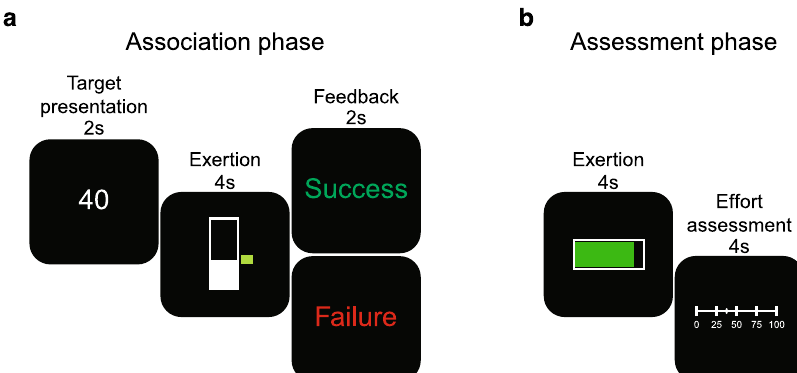
Fig. 1 Experimental paradigm. a Association phase; Participants were trained to associate between grip force exerted on a handheld dynamometer and effort levels from 0 to 100 (80% of maximum voluntary contraction (MVC)). Each trial began with presentation of the target, followed by an effortful grip with real-time visual feedback of the exerted force represented as a bar that increased in height with increased exertion. A target zone was also presented, and participants were asked to maintain their exerted force within this target zone. The target zone turned green when exerted force was within the target and stayed red otherwise. Feedback of success or failure was provided at the end of each trial. b Assessment phase; Participants were instructed to exert an unknown amount of force and assess how much they exerted. On each trial, the full bar corresponded to a target effort level that was unknown to participants. Successfully achieving the effort target resulted in the bar turning from red to green. Following exertion, participants selected the effort level they believed they had exerted. Participants were not given feedback about accuracy of their effort consistent with previous studies of isometric force production which have shown that variability in motor output increases proportionally with the amount of exertion (i.e., signal-dependent noise) 16 – 18 . In the PD group, we found that dopamine availability interacted with the effect of mean exertion on exertion variability (Fig. 2C; Linear mixed model, β = − 0.04, t = − 2.25, df = 1820, p = 0.025). When participants were in the ON dopamine condition, they exhibited less of an increase in exertion variability as exertion increased, compared to the OFF condition. We found that control participants ’ exertion variability matched participants in the OFF condition (Linear Mixed Model; β = − 0.0030912, t = − 0.11424, df = 2634, p = 0.90906, and the ON condition (Linear Mixed Model; β = − 0.042854, t = − 1.6234, df = 2634, p = 0.10462). These results align with our hypothesis of increased dopamine availability facilitating a reduction in exertion varia- bility during effortful motor output. During the assessment phase, we found that Control and (Fig. 2D; Linear mixed model, β = 1.226, t = 21.452, df = 2634, p = 3.1948e − 94) PD participants in the ON and OFF conditions (Fig. 2D; Supplementary Table 3; Linear mixed model, β = 1.24, t = 17.49, df = 1820, p = 1.91e − 63), recalled assessments of effort increased with their mean exertion. In the PD group, there was a signi fi cant interaction between dopamine treatment condition and mean exertion on assessments of effort (Linear mixed model; Fig. 2D; β = − 0.23, t = − 2.79, df = 1820, p = 0.005), indicative of increased dopamine availability having a dampening effect on increases in effort assessment with exertion. To further assess how dopaminergic availability was related to participants ’ accuracy of effort assessment we examined the slope of the relationship between participants ’ mean exertion and levels of assessment - perfect effort assessment would result in a slope of unity. In the dopamine OFF condition, the average slope was signi fi cantly greater than unity ( β = 1.25 ± 0.07, t-stat = 3.36, df = 18, p -value = 0.0035), corresponding to overassessment of effort in a dopamine depleted state. In the dopamine ON condition, we failed to fi nd a signi fi cant difference in slope from unity ( β = 1.01 ± 0.09, t-stat = 0.11, df = 18, p -value = 0.91), sug- gesting that dopamine had a protective effect on effort assessment accuracy. Control participants ’ effort assessments matched participants in the dopamine OFF condition (Linear Mixed Model; β = 0.0126, t = − 0.139, df = 2634, p = 0.89), and assessments were lower in the dopamine ON condition compared